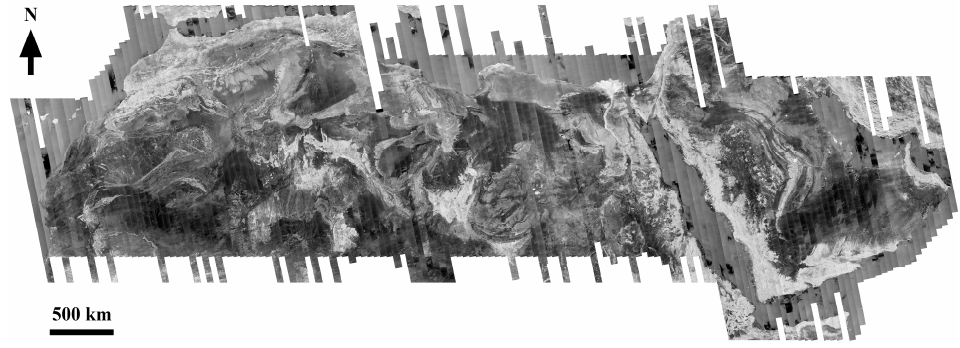
Figure 2. PALSAR strips acquired by the Japanese space agency (JAXA) over the Sahara and Arabia during the summer of 2017.